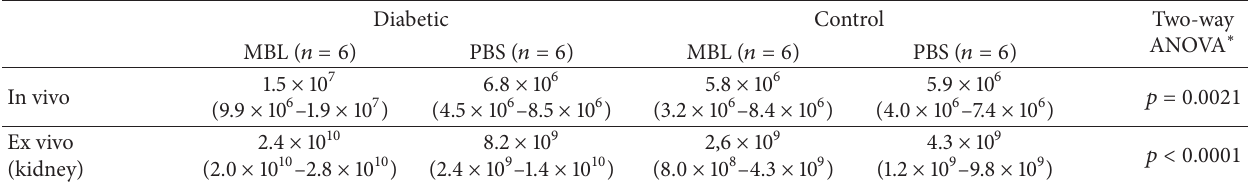
Table 1: Summarized data and statistical information of in vivo and ex vivo imaging of diabetic and nondiabetic